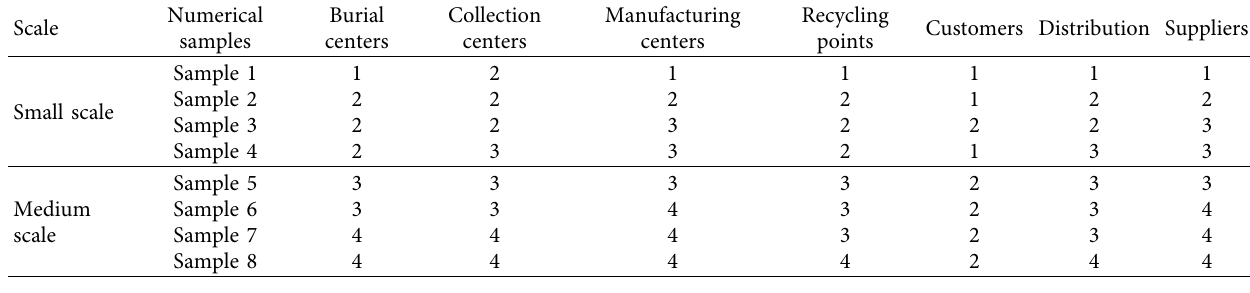
Table 4: Scale of numerical examples.